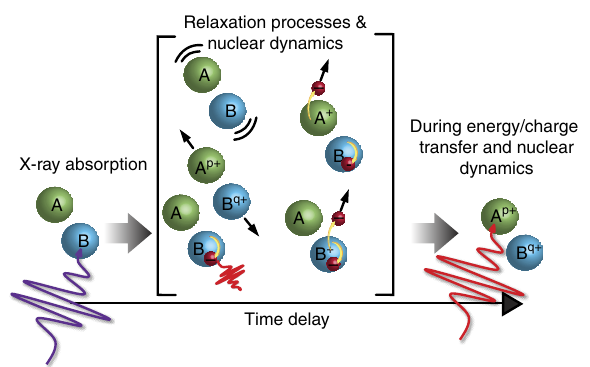
Figure 1 | Hetero-site X-ray pump-probe scheme. Sketch of a two-colour X-ray-pump/X-ray-probe experiment. The X-ray absorbed by B induces inner-shell electronic excitation, ionization, fluorescence, Auger-electron emission and charge redistribution to site A. Nuclear dynamics is also induced—dissociation, isomerization and vibrational excitation. The site-to- site intramolecular dynamics is explored by absorbing a second X-ray at site A after a controlled delay. With this approach, it is possible to characterize the response at one site of the molecule when an X-ray photon has been absorbed in another site of the same molecule.